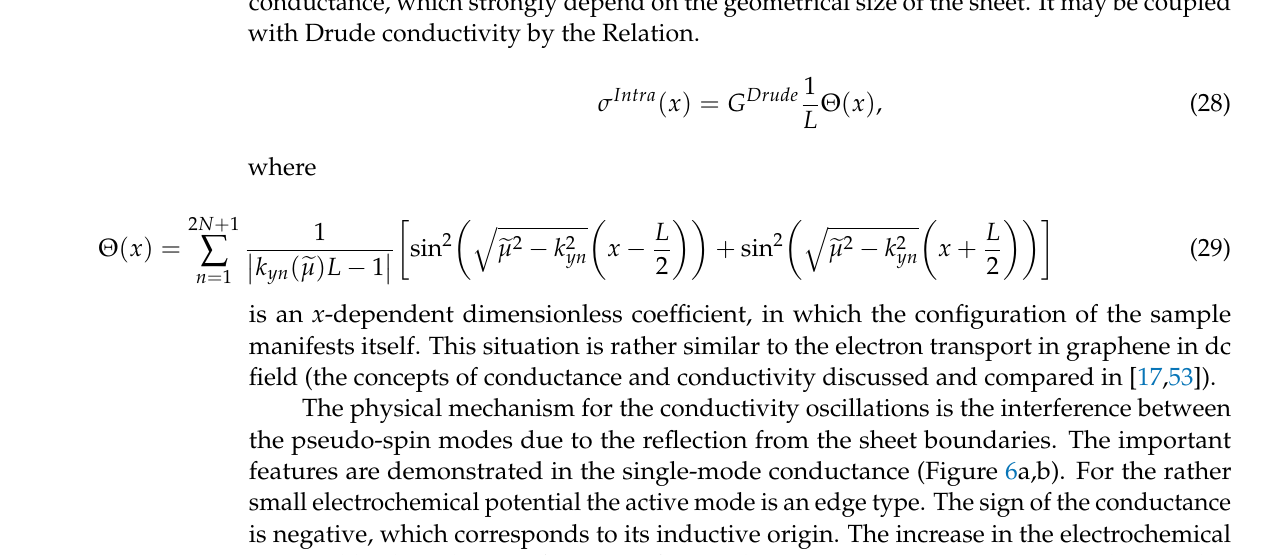
Figure 5. The spatial distribution of the conductance in the units G Drude / Ll . L = 800 nm, µ = 1.0 eV.